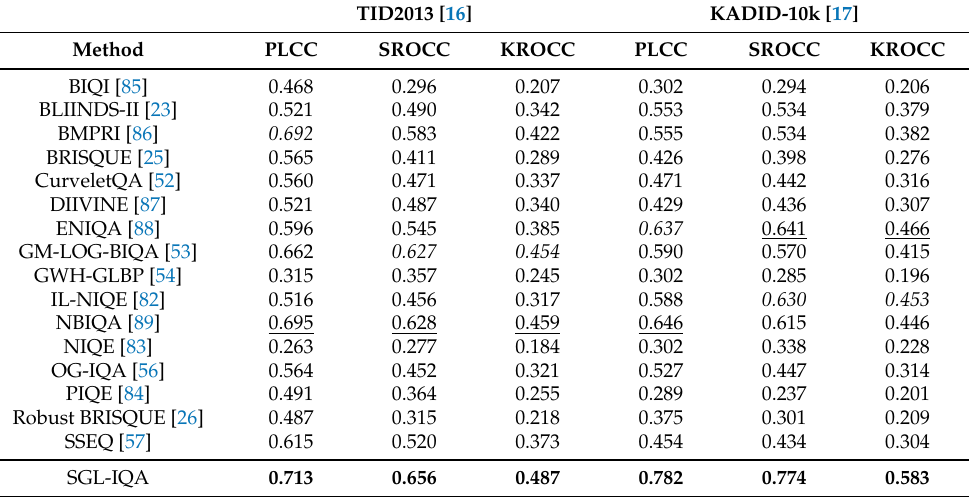
Table 6. Comparison to other state-of-the-art algorithms using TID2013 [16] and KADID-10k [17] databases. Median PLCC, SROCC, and KROCC values were measured over 100 random train- test splits carried out with respect to the reference images. The best results are given in bold, the second-best results are underlined, and the third-best results are given in italics.